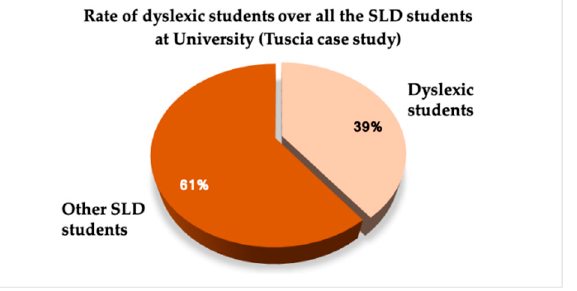
Figure 3. Rate of dyslexic students over all the SLD students attending university, according to the Tuscia case study.